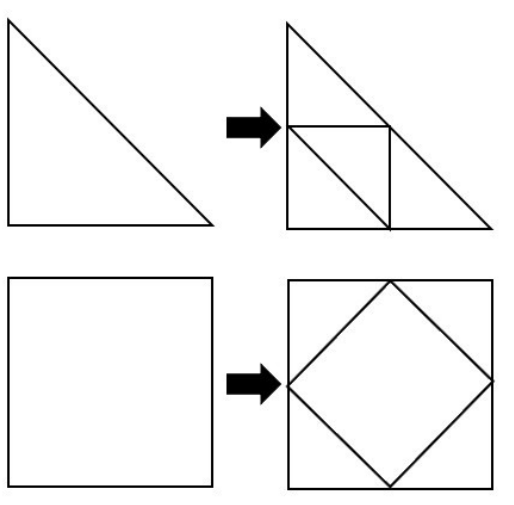
Figure 5. Refinement of triangular structure and quadrangular structure.